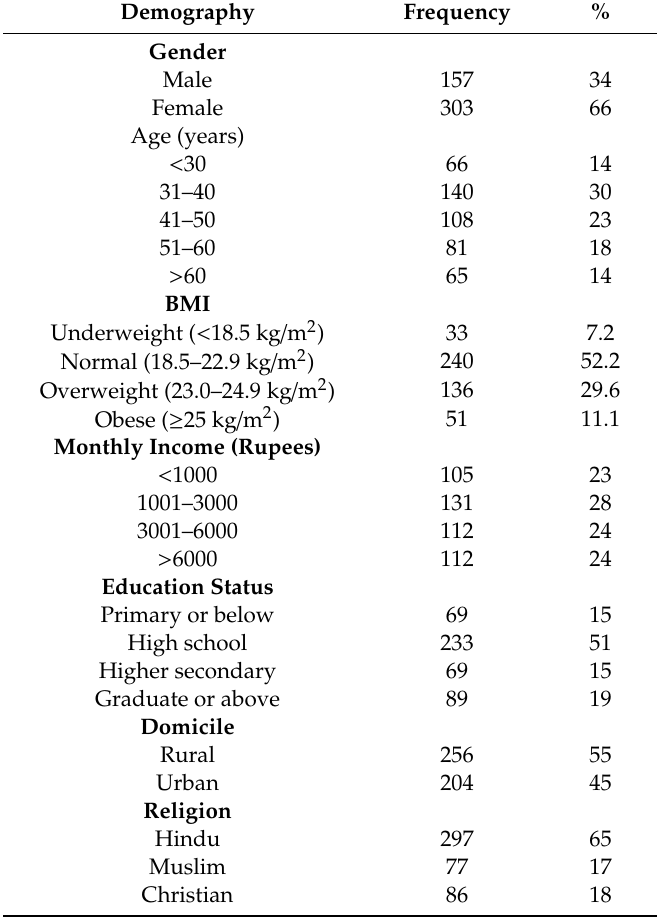
Table 1. Summary of the socio-demographic characteristics of study participants ( n =